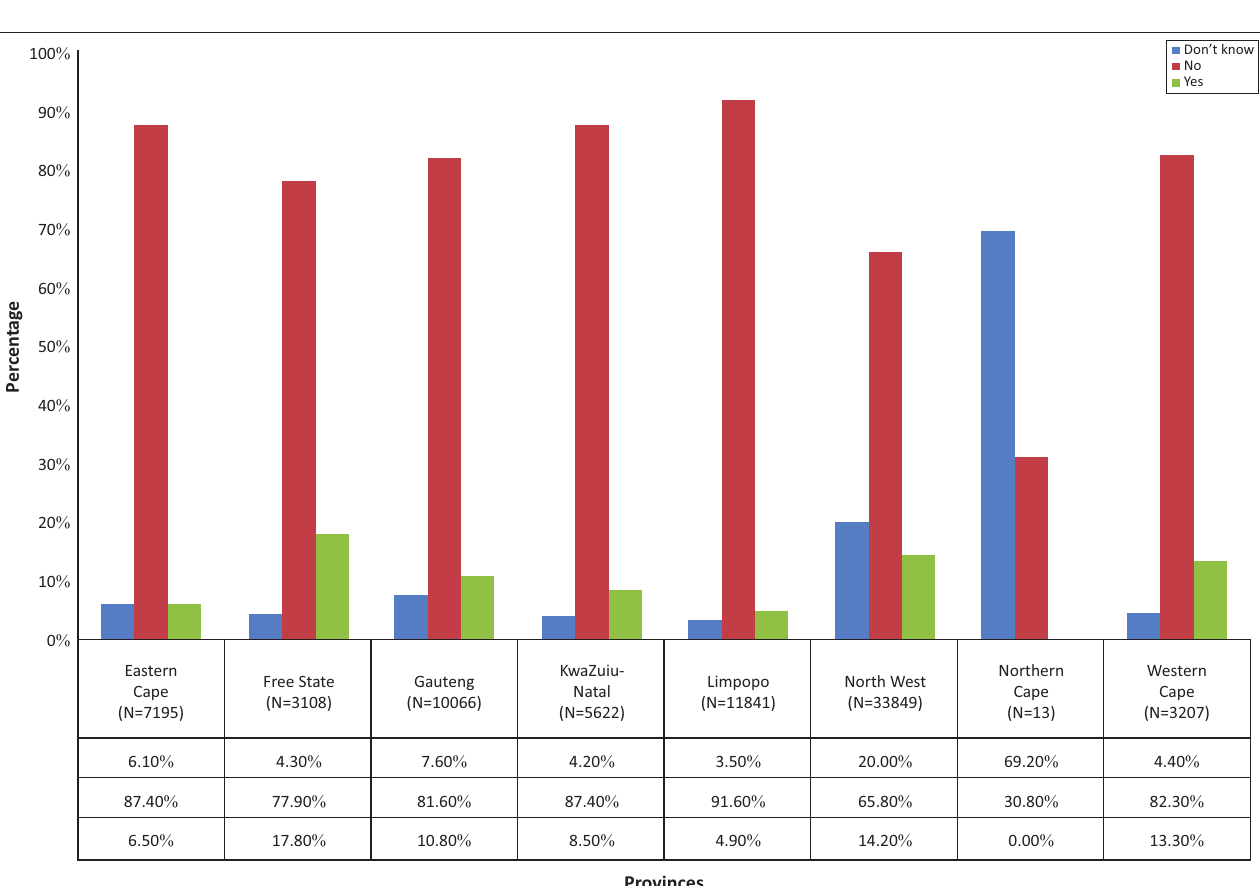
FIGURE 3: Self-reported vision difficulty in the nine provinces of South Africa.